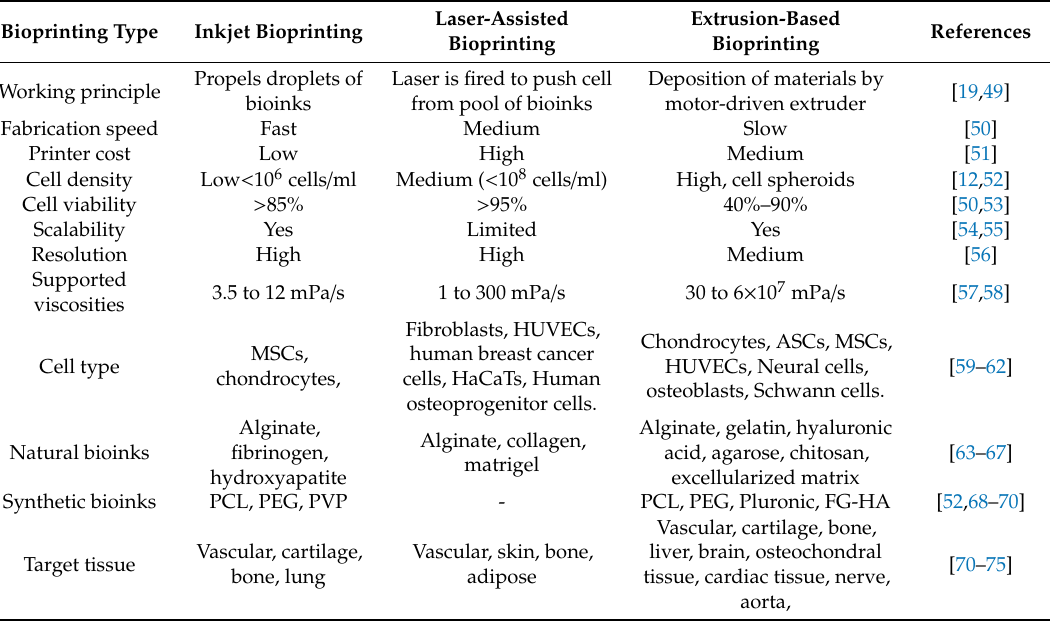
Figure 3. The simplified procedure of different kinds of 3D bioprinting. ( a ) Inkjet bioprinting; ( b ) laser-assisted bioprinting; ( c ) extrusion-based bioprinting. Reprinted with permission from Reference [12]. Table 1. Comparison of different kinds of 3D bioprinting.